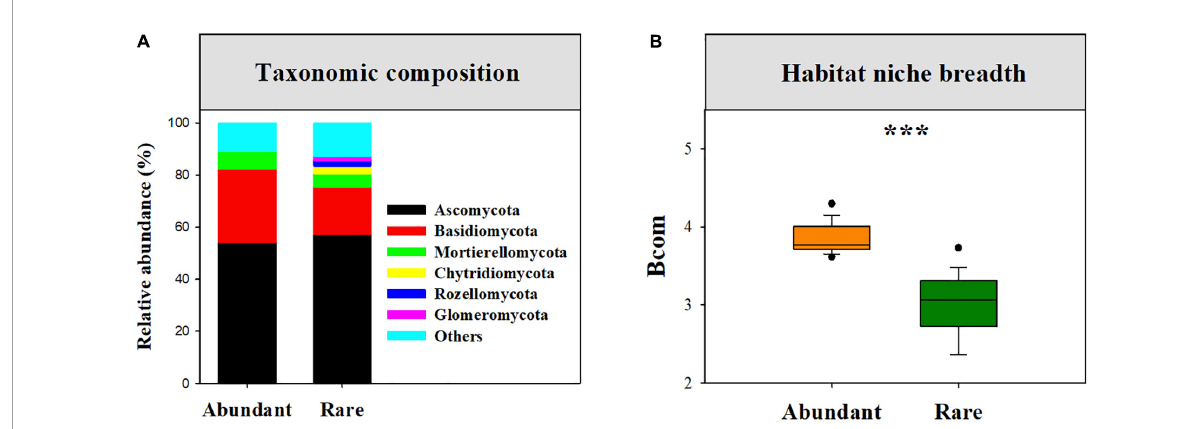
FIGURE1 The taxonomic composition of rare and abundant fungal sub-communities (A) , and the difference in mean habitat niche breadths ( Bcom ) between abundant and rare fungal subcommunities (B) , and *** P < 0.0001; Wilcoxon rank-sum test.